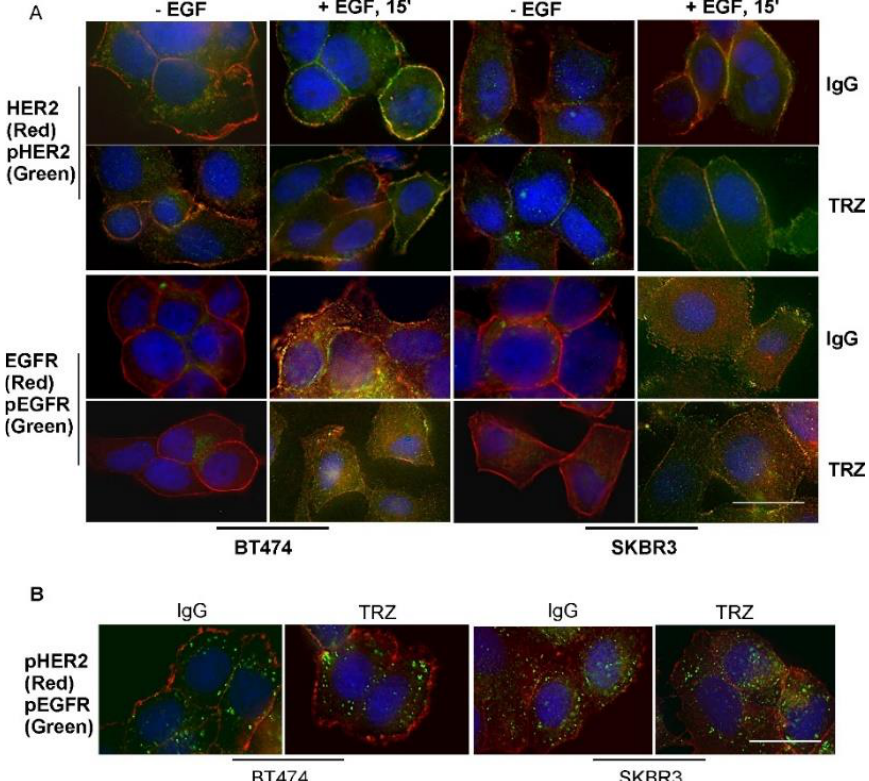
Figure 5. The effects of trastuzumab on EGF-induced phosphorylation of EGFR and HER2 in BT474 and SKBR3 cells. Cells were incubated with TRZ (10 µg/mL) or human IgG for 1 h and then stimu- lated with EGF (50 ng/mL). ( A ) Following EGF stimulation for 15 min, the phosphorylation of EGFR and HER2 (green) was determined by antibody to phosphorylated EGFR (pEGFR, pY1086) and pHER2 (pY1139), respectively. The localization of EGFR and HER2 (red) was determined by anti- bodies to by total EGFR and HER2, respectively. Yellow indicates the co – localization. the size bar = 20 µm. ( B ) Localization of pEGFR (pY1086) and pHER2 (pY1139) following EGF stimulation for 30 min. the size bar = 20 µm.